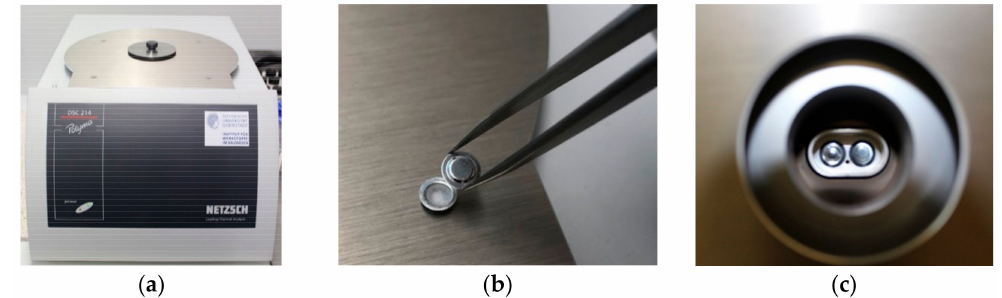
Figure 1. ( a ) Di ff erential Scanning Calorimetry (DSC) 214 Polyma equipment from company Netzsch (Selb, Germany, with a T work range − 170 ◦ C to 600 ◦ C — Heating / Cooling rate 0.001 K / min to 500 K / min — Indium Response Ratio > 100 mW / K — Resolution (technical) 0.1 µ W — Enthalpy precision ±